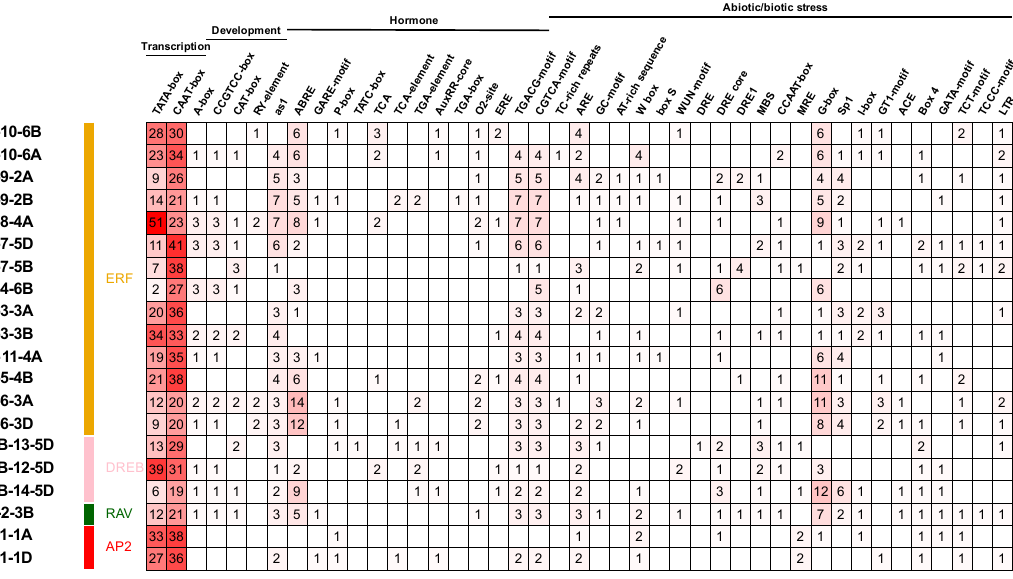
Figure 4. Main predicted cis -acting elements in TaAP2/ERF promoters. Four types of cis -acting elements (transcription-associated; development-associated; hormone-associated; and abiotic stress- associated) were identified in the promoter regions ( − 2000 bp).